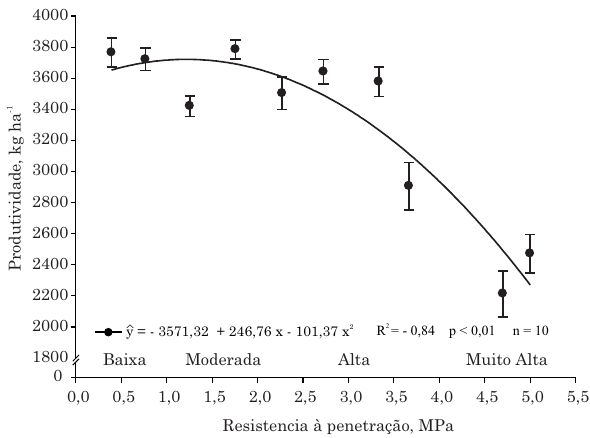
Figura 4. Produtividade da cultura da soja em função da resistência da penetração, determinada após o manejo da cultura de cobertura e classificada de acordo com Arshad et al. (1996), em Latossolo Vermelho na safra de 2008/09, muito